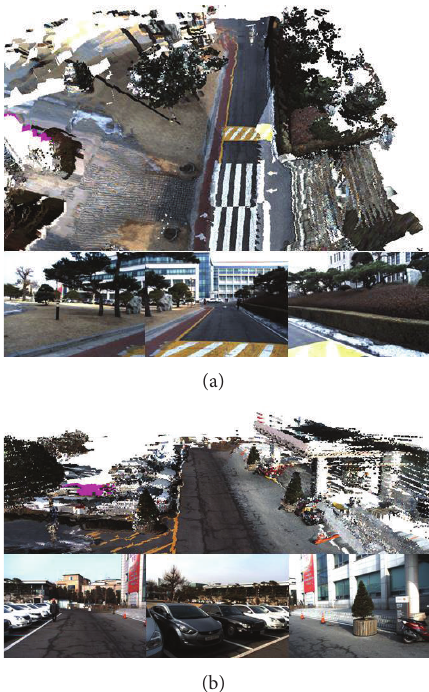
Figure 16: Terrain reconstruction results from the nonground PDB, ground MDB, and TDB. (a) A top view of environment 1. (b) A front view of environment 2.